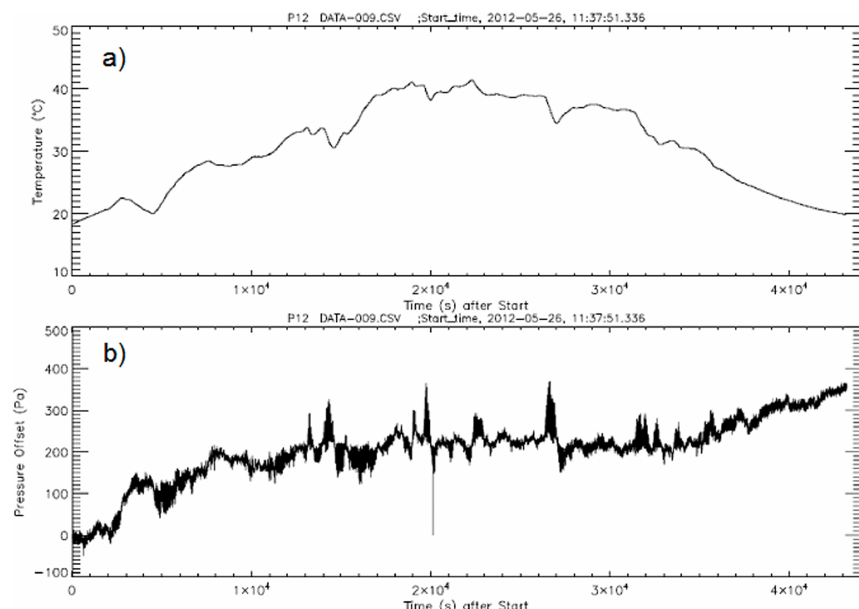
Fig. 7. Example data from a logger (“P12”) during a follow-up measurement campaign, showing about 12h of data. (a) Sensor temperature rises throughout the day to a peak (in the shade) of 40 ◦ C. Note that dips in temperature occur at ∼ 5000s intervals. The timestamp on the data files is Eastern Daylight Time (from the author’s laptop), which is 3h ahead of local time (Pacific). Thus, the record shown here begins at 08:38a.m.LT (local time). (b) Pressure record, with an initial offset subtracted. Fluctuations of ∼ 10Pa are seen throughout, but some isolated bursts of ∼ 100Pa noise are seen, correlating with the temperature dips; the instance at 27000s is shown in more detail in Fig.